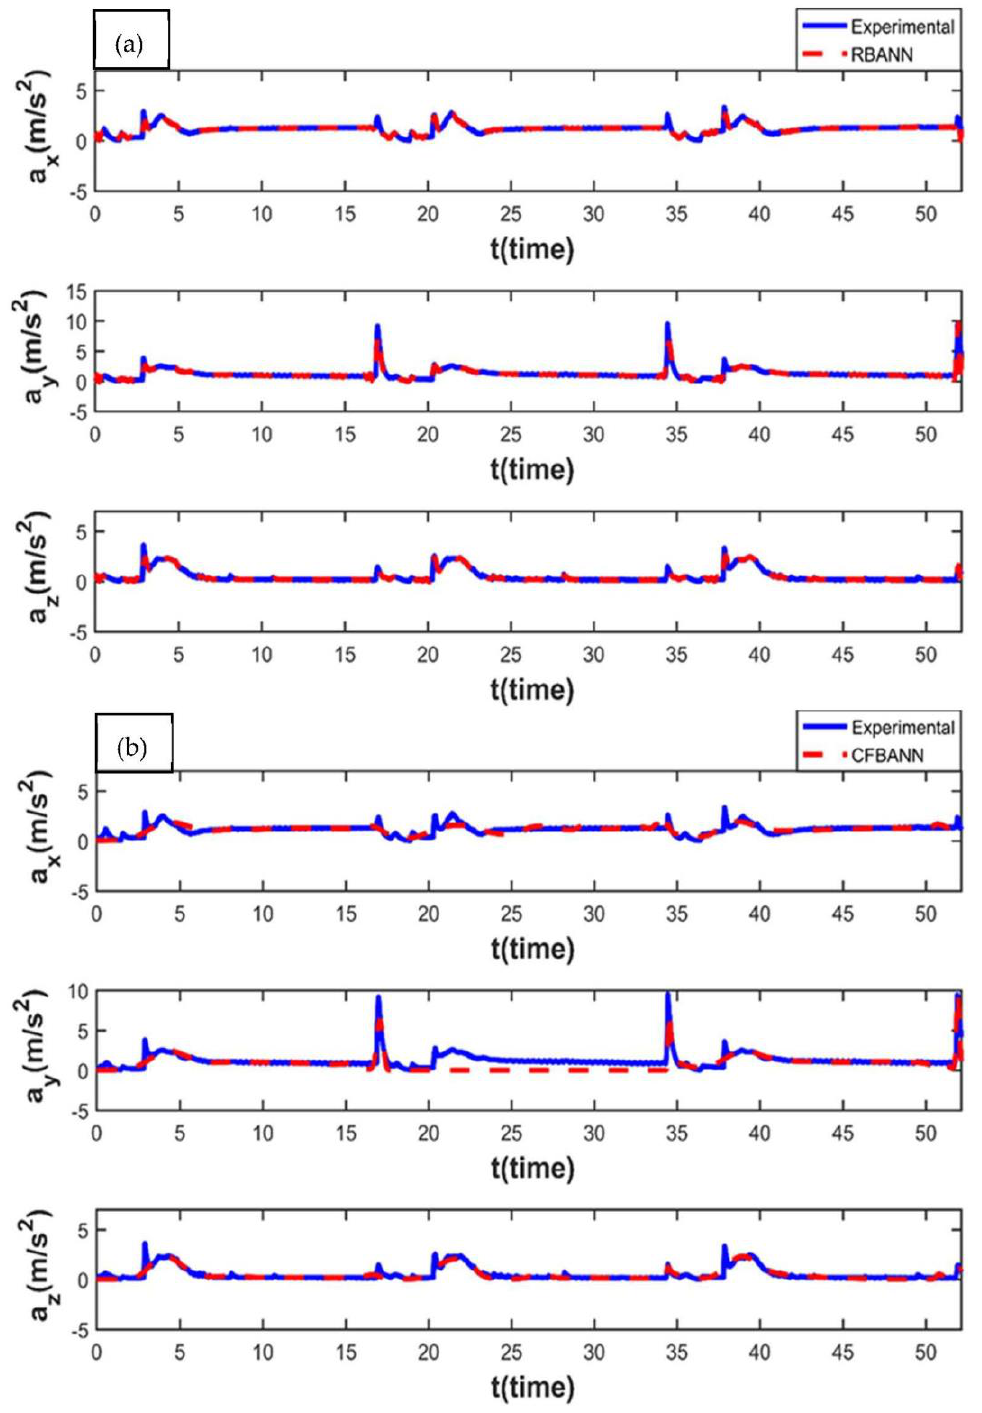
Figure 12. Experimental and ANN results obtained for the working condition of 14 s and 18.75 bar: ( a ) RBANN; ( b ) CFBANN.